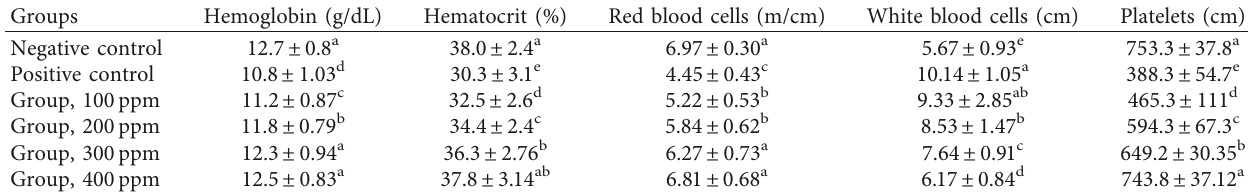
Table 3: Complete blood